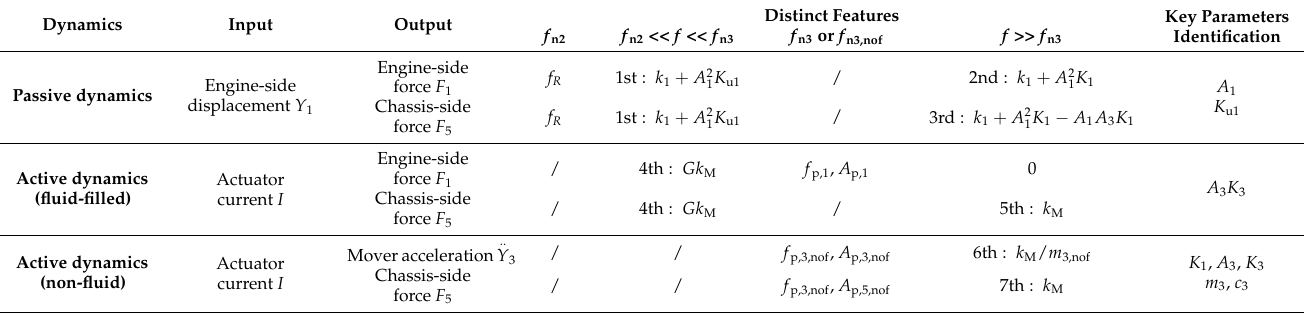
Table 1. Dynamics and distinct features of